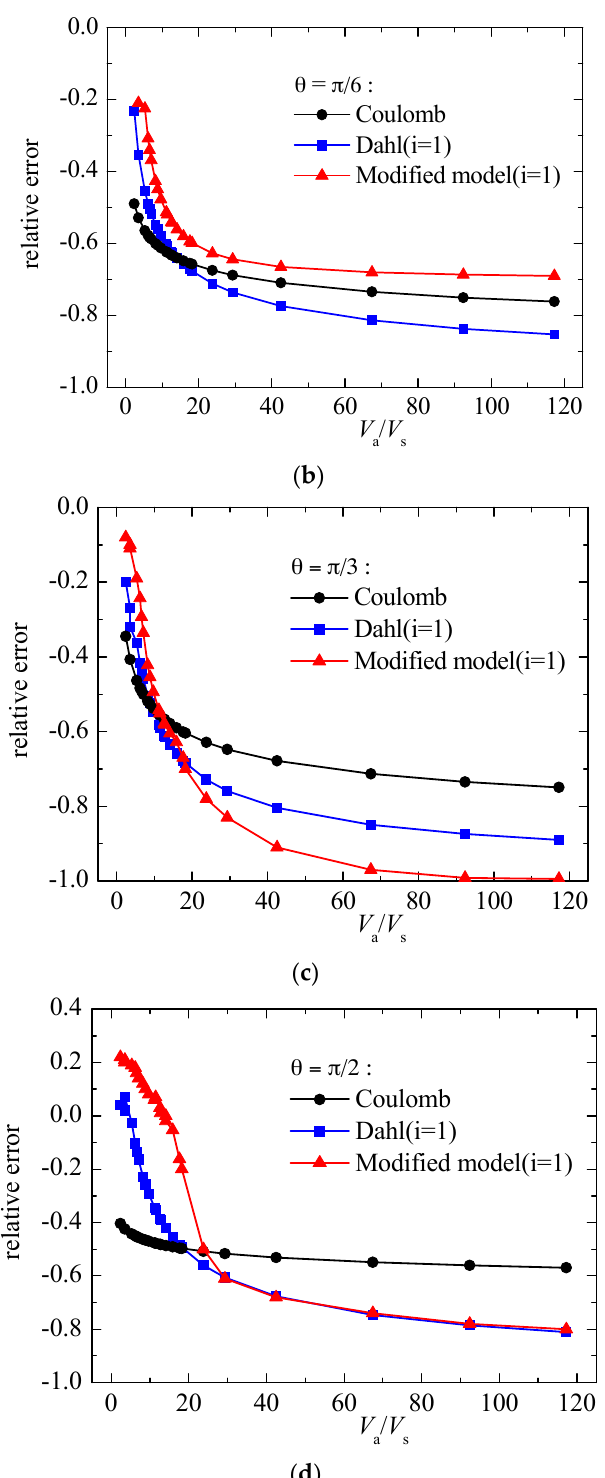
Figure 13. Relative error of modified model compared with Coulomb and Dahl models. ( a ) θ = 0 ; ( b ) θ = π/6 ; ( c ) θ = π/3 and ( d ) θ = π/2 .